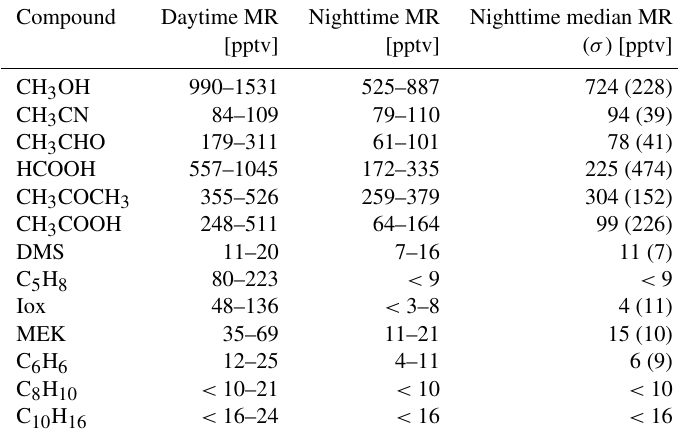
Table 2. Interquartile range of 30min average (O)VOC mixing ratios (MR) recorded at the remote high-altitude Maïdo observatory during nighttime (22:00–05:00LT, FT) and daytime (10:00–17:00LT, remote PBL). The last column indicates the median 30min average mixing ratio during nighttime with the standard deviation between parentheses. If the limit is below the limit of detection (LoD), we put < LoD. Compound Daytime